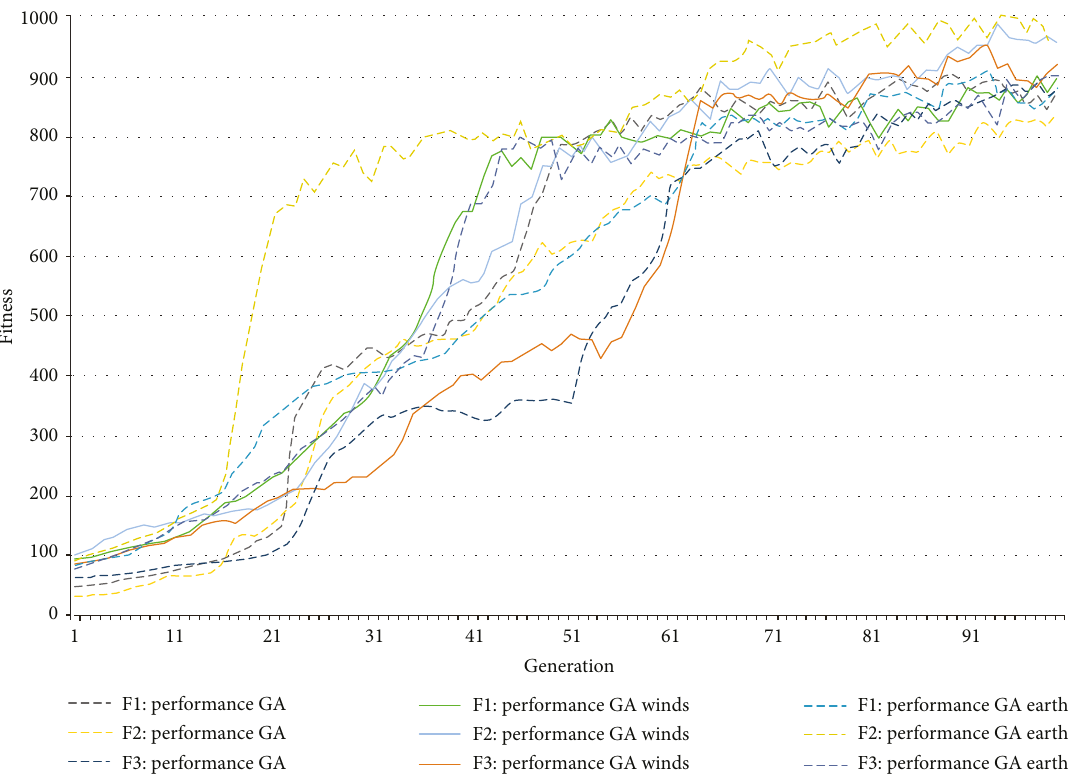
Figure 3: Evolution of the results in each generation with test functions F1, F2, and F3 using GA, GAP winds, and GAP earthquake.